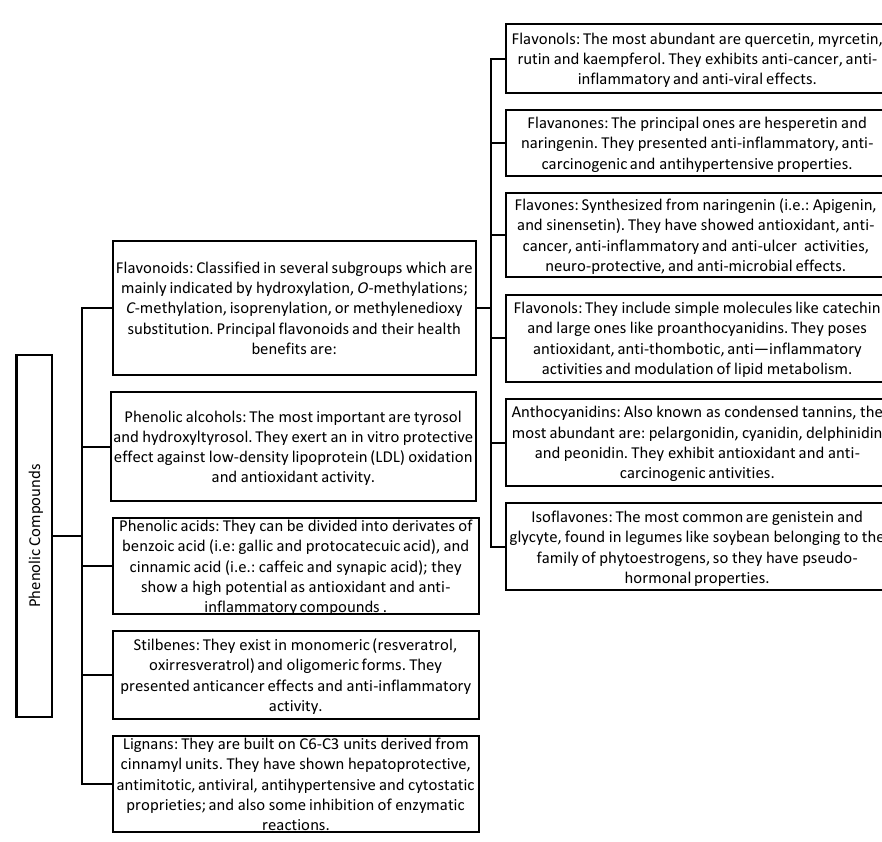
Figure 1. General classification of phenolic compounds [16,17].